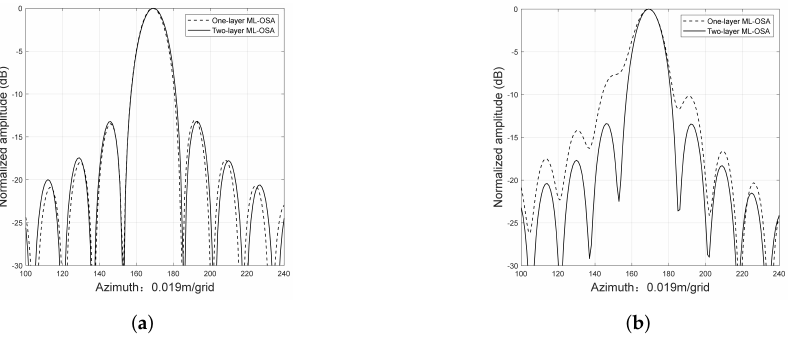
Figure 17. The azimuth profiles processed by the parameter-adjusting one-layer ML-OSA and two-layer ML-OSA of ( a ) Point 6 and ( b ) Point 7 in Figure